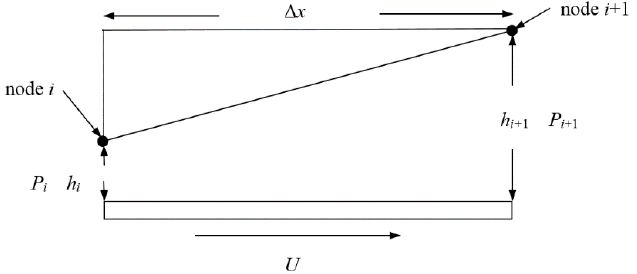
Figure 8. Surface interpolation between nodes for stress factor calculation.